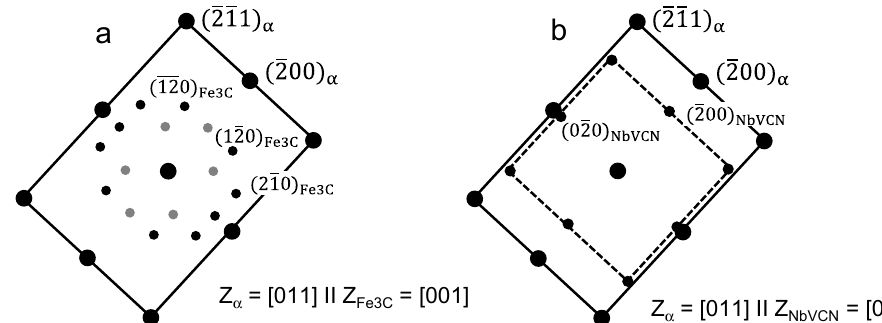
Figure 7. Analysis of the diffraction patterns characteristic for the studied steel in all processing conditions: ( a ) Fe 3 C and ( b ) NbV-rich carbide.